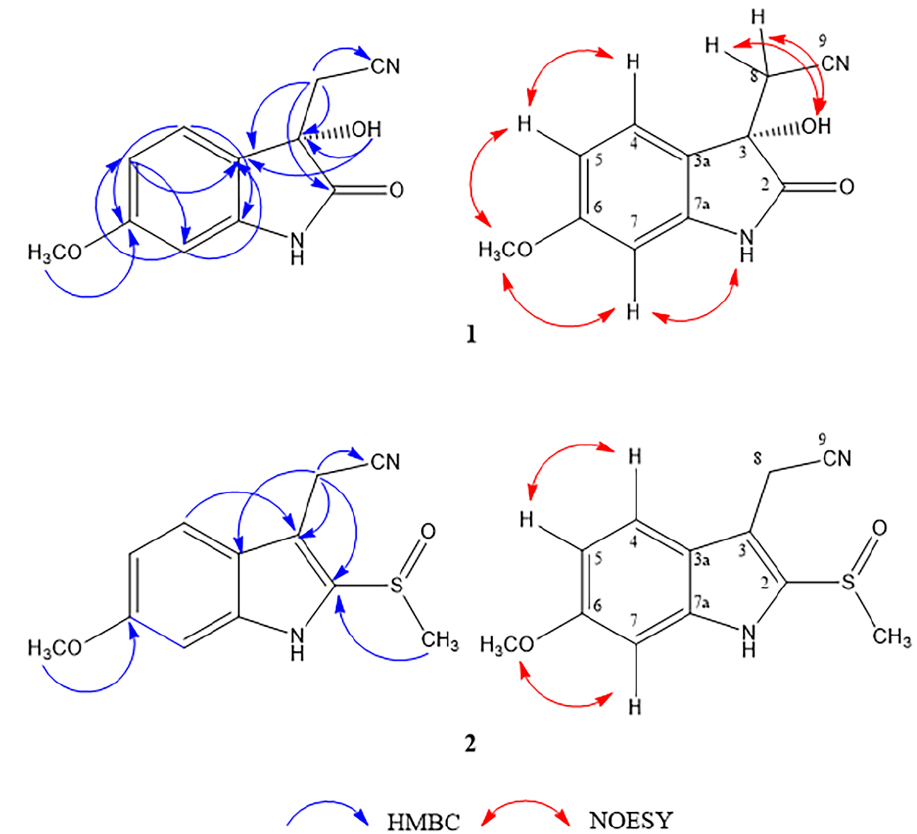
Figure 1. Key HMBC and NOESY correlations of compounds 1 – 2 . Compound 3 was isolated as a reddish-brown amorphous solid. The molecular for- mula was deduced to be C 13 H 16 N 2 O 2 S (IHD 7), according to a pseudo-molecular [M + H] + ion peak at m / z 265.0999 in the HR-ESI-MS (calcd. for C 13 H 17 N 2 O 2 S, 265.1005). The IR spec- trum showed absorption bands of amine NH (3370 cm −1 , broad), O-methyloxime, and the aromatic ring (1628, 1579, 1457 cm −1 ) [16]. The 1 H- and 13 C-NMR spectroscopic data (Table 2) showed resonances of an ABX spin system at δ H 7.33 (1H, d, J = 8.8 Hz, H-4), 6.84 (1H, d, J = 2.4 Hz, H-7), and 6.64 (1H, dd, J = 8.8, 2.4 Hz, H- 5), an olefinic proton at δ H 7.03 (1H, d, J = 2.0 Hz, H-2), one aliphatic methy lene at δ H 3.80 (2H, s, H- 8), an indole NH at δ H 10.72 (1H, br s, NH- 1), two methoxy groups at δ H 3.85 (3H, s, NOCH 3 ) and 3.74 (3H, s, 6-OCH 3 ) and one methylthio group at δ H 2.17 (3H, s, SCH 3 ). The difference in the structure of this compound from compound 2 is the absence of a substituent on C-2, as supported by a 1 H- 1 H COSY correlation of NH-1/H-2, and the presence of substituted imine, instead of nitrile, in its side chain. A methylthio group was located at C-9 on the imine double bond, based on an HM BC correlation between its methyl signal (δ H 2.17) to C- 9 (δ C 157.8), and a meth- oxy group (δ H 3.85, δ C 61.5) was placed on the nitrogen atom of this imine bond as an O- methyloxime substructure based on the comparison of its chemical shift with that of 2- isopropyl-5-methylcyclohexanone O-methyloxime [16]. The methyl-N-methoxyethanimi- dothioate-2-yl substitution at C-3 was confirmed by HMBC correlations of H-8 methylene signals (δ H 3.80) to C- 2 (δ C 123.1), C- 3 (δ C 107.8), C- 3a (δ C 126.5), and C-9 (Figure 2). The cis orientation between the N-OCH 3 and SCH 3 groups was suggested by the lowest relative energy computation based on a DFT calculation at a B3LYP/6-31g (d,p) level (Section 2.2). Therefore, the chemical structure of 3 was proposed to be methyl ( Z )- N -methoxy-2-(6- methoxy-1 H -indol-3-yl)ethanimidothioate and named maeroxime A. Sulfur-containing indole derivatives from M. siamensis could be phytoalexins similar to those found in Bras- sicaceae plants, and glutathione- S -transferase (GST) might be involved in the biosynthesis of these phytochemicals [17]. Compound 4 was obtained as an orange-brown amorphous solid. Its molecular for- mula of C 13 H 14 N 2 O 3 S (IHD 8), determined from the HR-ESI [M + H] + ion peak at m / z